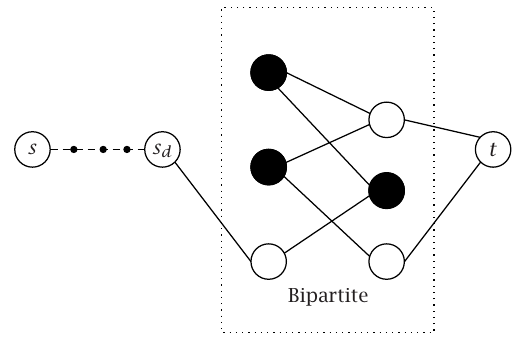
Figure 3.1 . Graph G (cid:5) constructed from bipartite G and constant d .